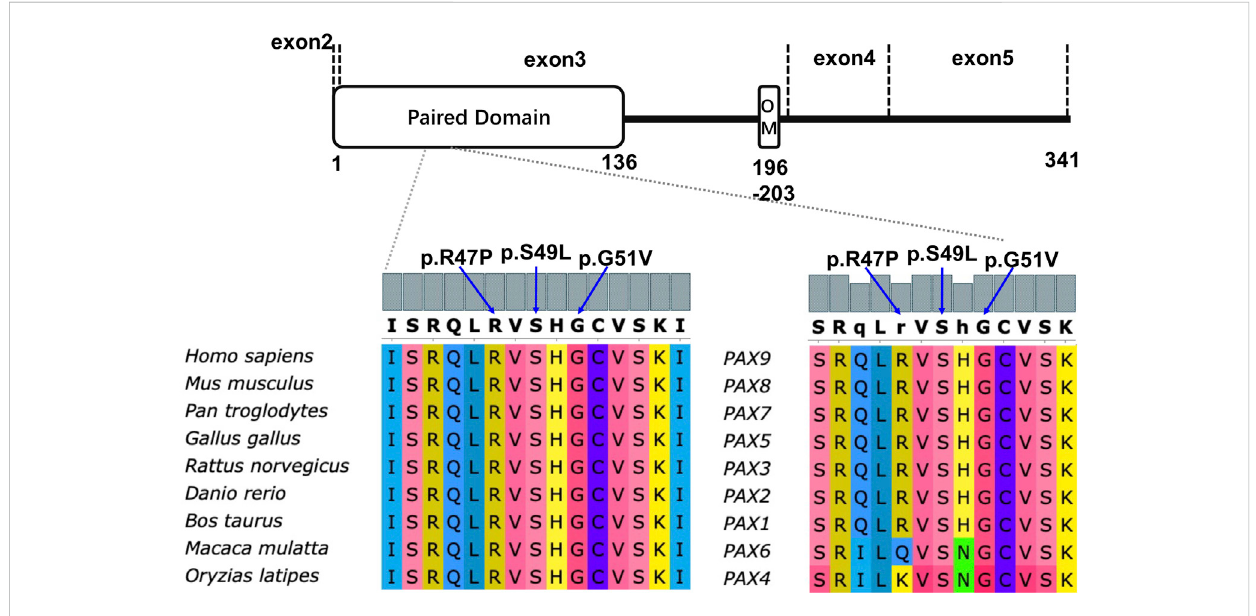
FIGURE 2 Schematic diagram of PAX9 protein (NP_006185.1) and conservation analysis of affected amino acids in paired domain among nine different vertebrate species and all PAX paralogs of homo sapiens .